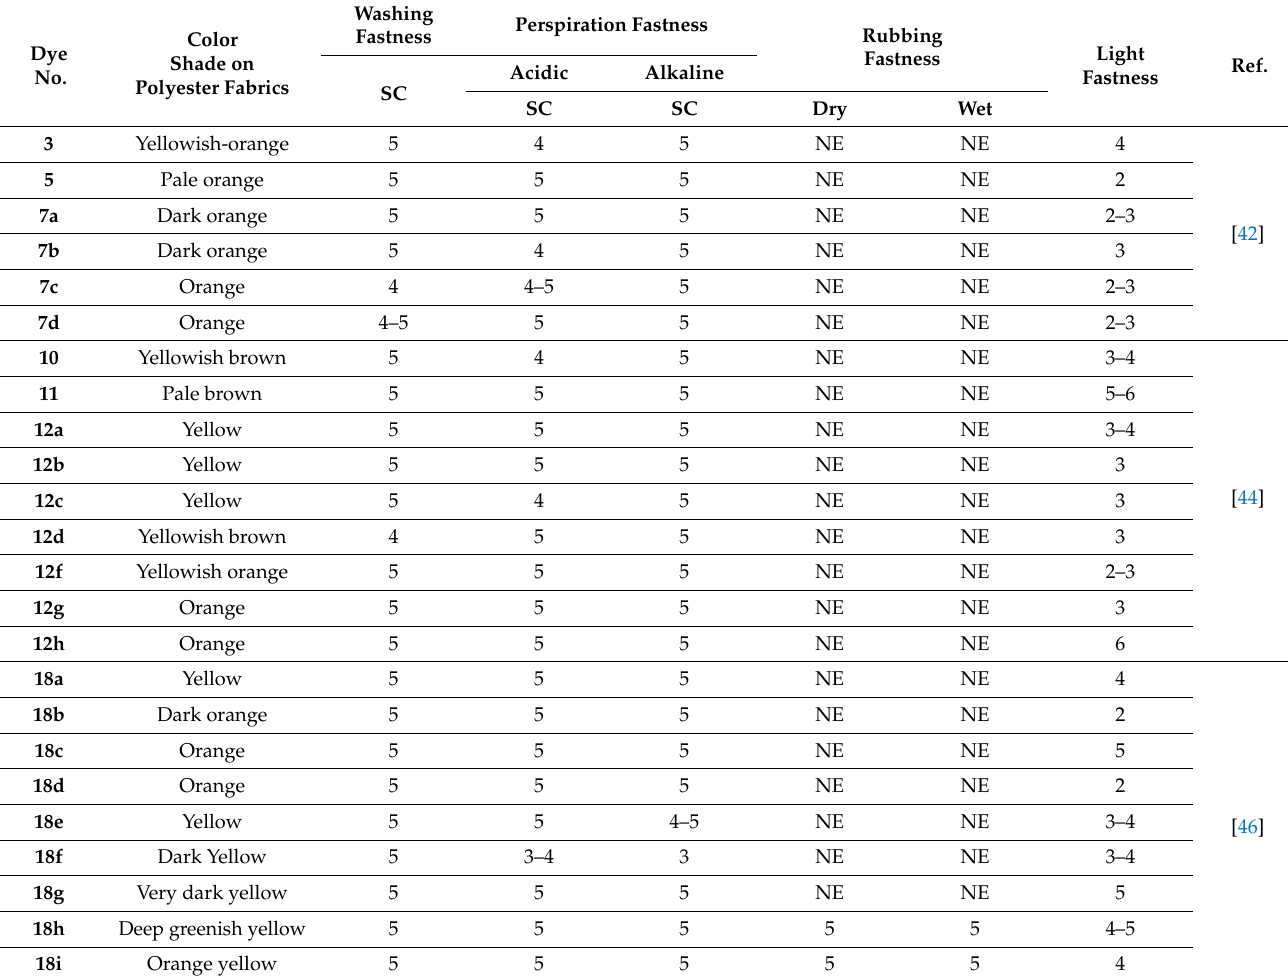
Table 3. Fastness properties of the polyester dyed fabrics with disperse